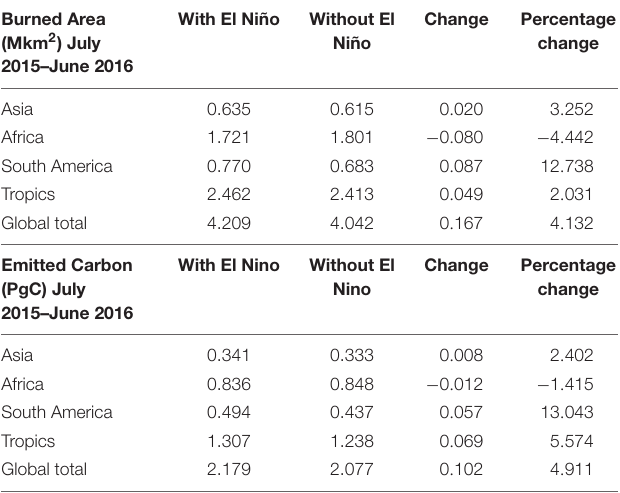
TABLE 1 | Burned area and emitted carbon globally and by region, with and without El Niño for total burned area (Mkm 2 ) and emitted carbon (PgC) simulated by